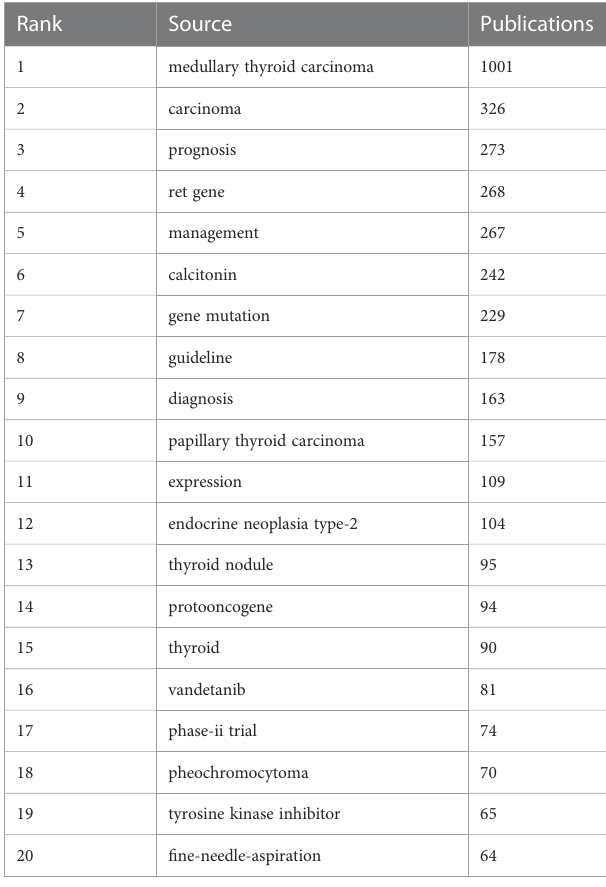
TABLE 5 The top 20 keywords in the MTC research fi